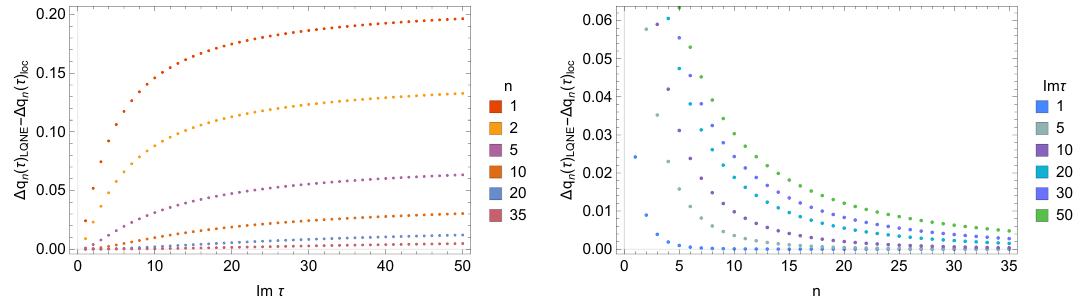
Figure 2 . Difference between the lqne prediction and the localization estimate for the first variation ∆ as function of Im( τ ) for fixed values of n (left) and as function of n for fixed values of Im( τ ) n q n (right). Note that the agreement between the lqne and the exact result is best at strong coupling and worst (though still extremely precise) at weak coupling, as expected from the interpretation of the exponentially small correction as attributable to the breakdown of the eft from the macroscopic propagation of a massive hypermultiplet, whose mass goes as the square root of the gauge coupling.